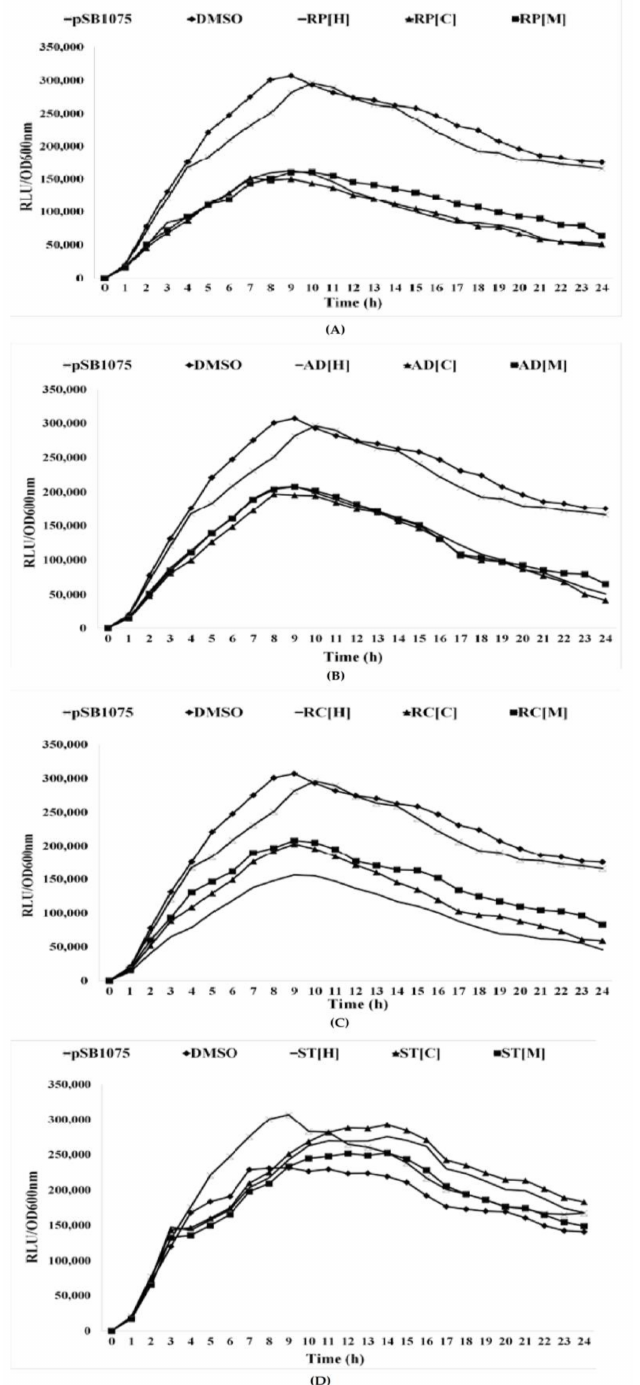
Figure 3. The inhibition of bioluminescence in E. coli [pSB1075] after being treated with 1 mg/mL of plant extracts in hexane, chloroform and methanol. ( A ) R. pini ( B ) A. dahurica ( C ) R. cibotii ( D ) S. tenuifolia , with DMSO served as negative control. All the plant samples show positive results in reducing bioluminescence production in E. coli [pSB1075], except for S. tenuifolia